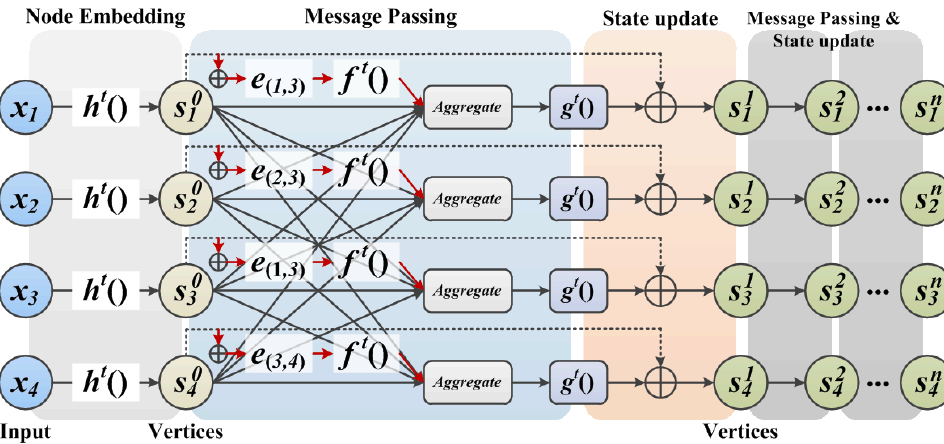
Figure 9. The message passing and state updating process of our